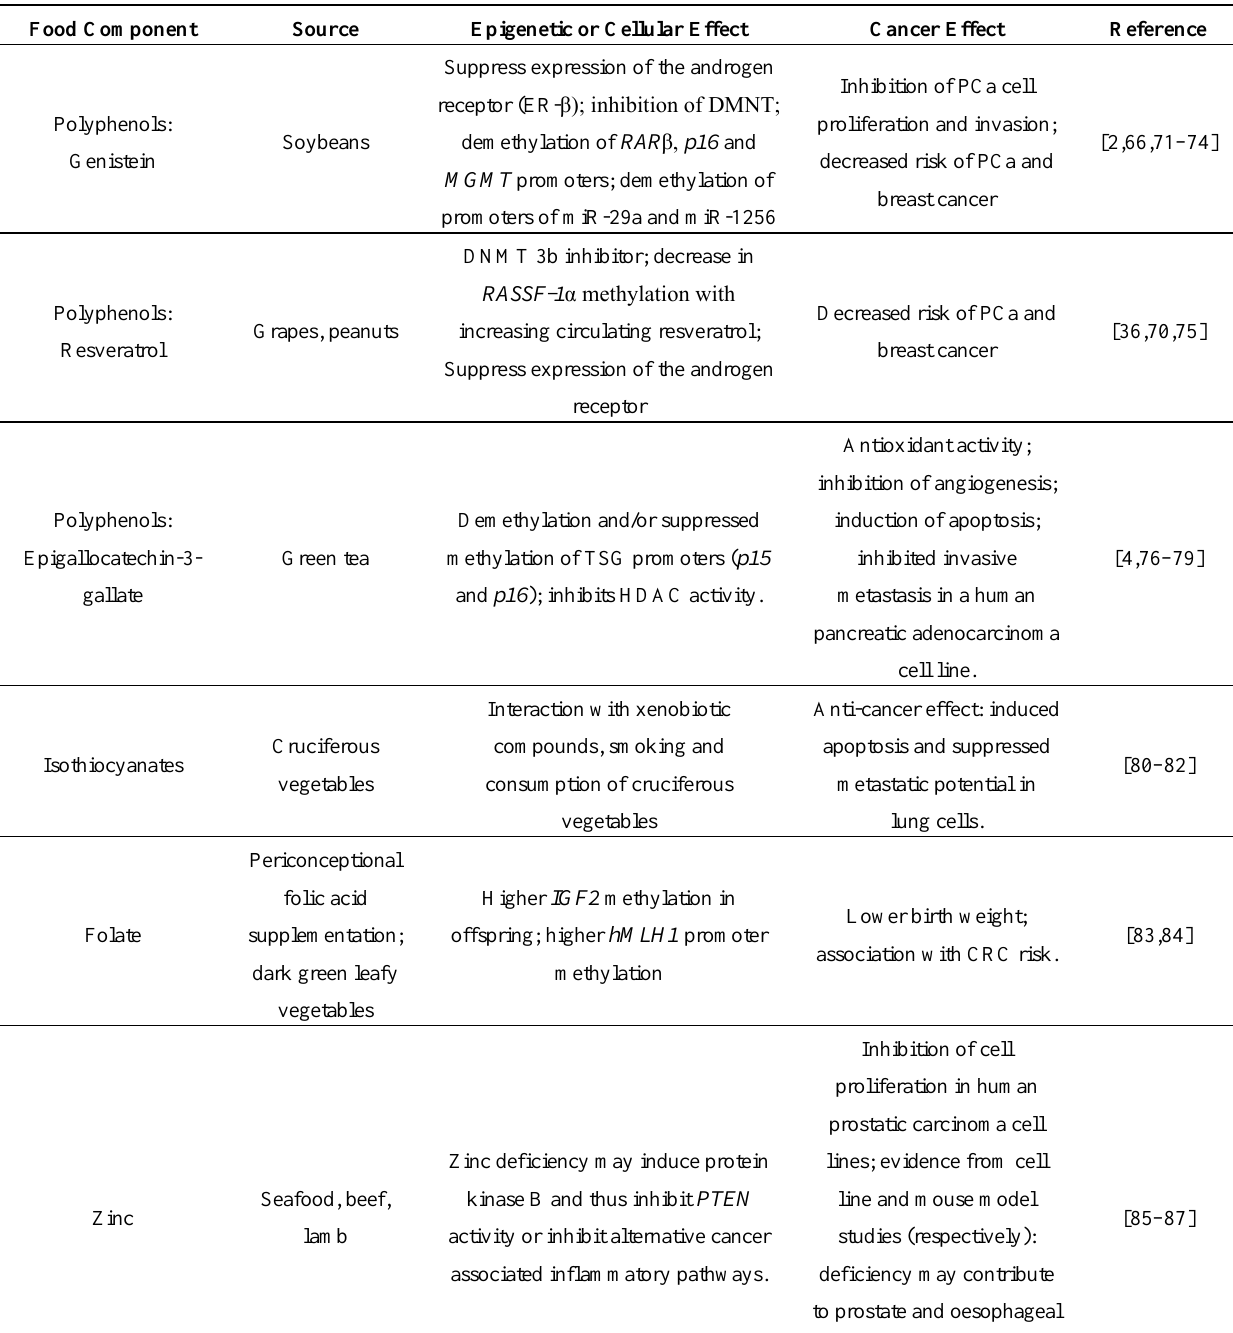
Table 1. A summary of the epigenetic and anti-cancer effects of food components. Food